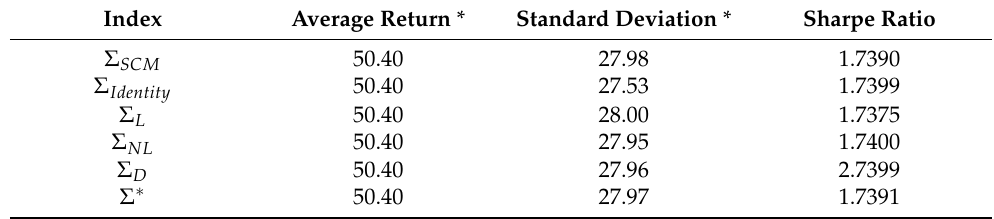
Table 6. The out-of-sample performance comparison between each estimator of the 41 assets in SSE50. Index